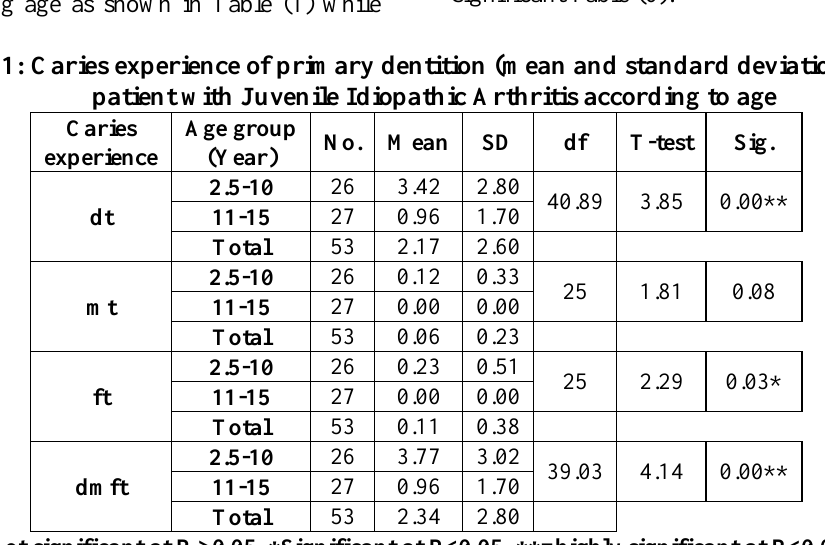
Table 2: Caries experience of permanent dentition (mean and standard deviation) among